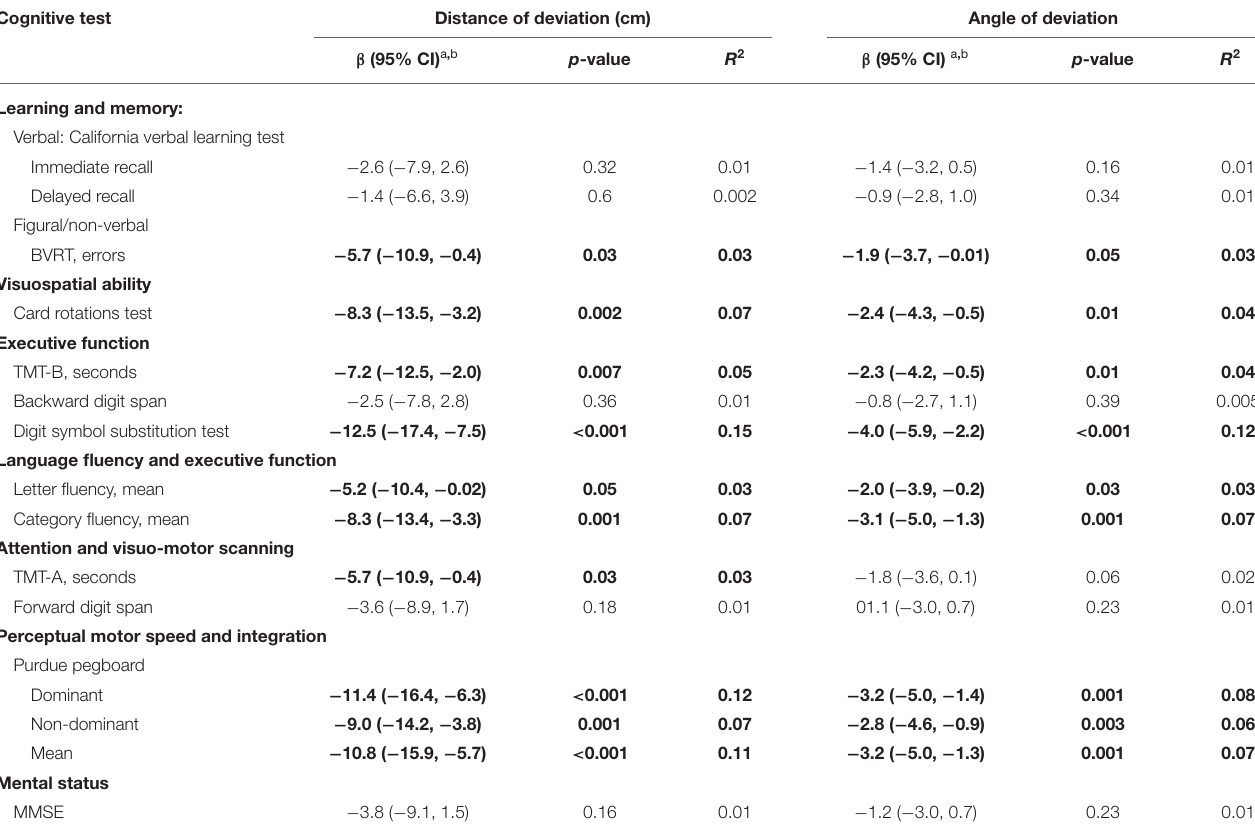
TABLE 2 | Simple linear regression of deviation on the triangle completion task and cognitive function tests in the Baltimore Longitudinal Study on aging. Cognitive